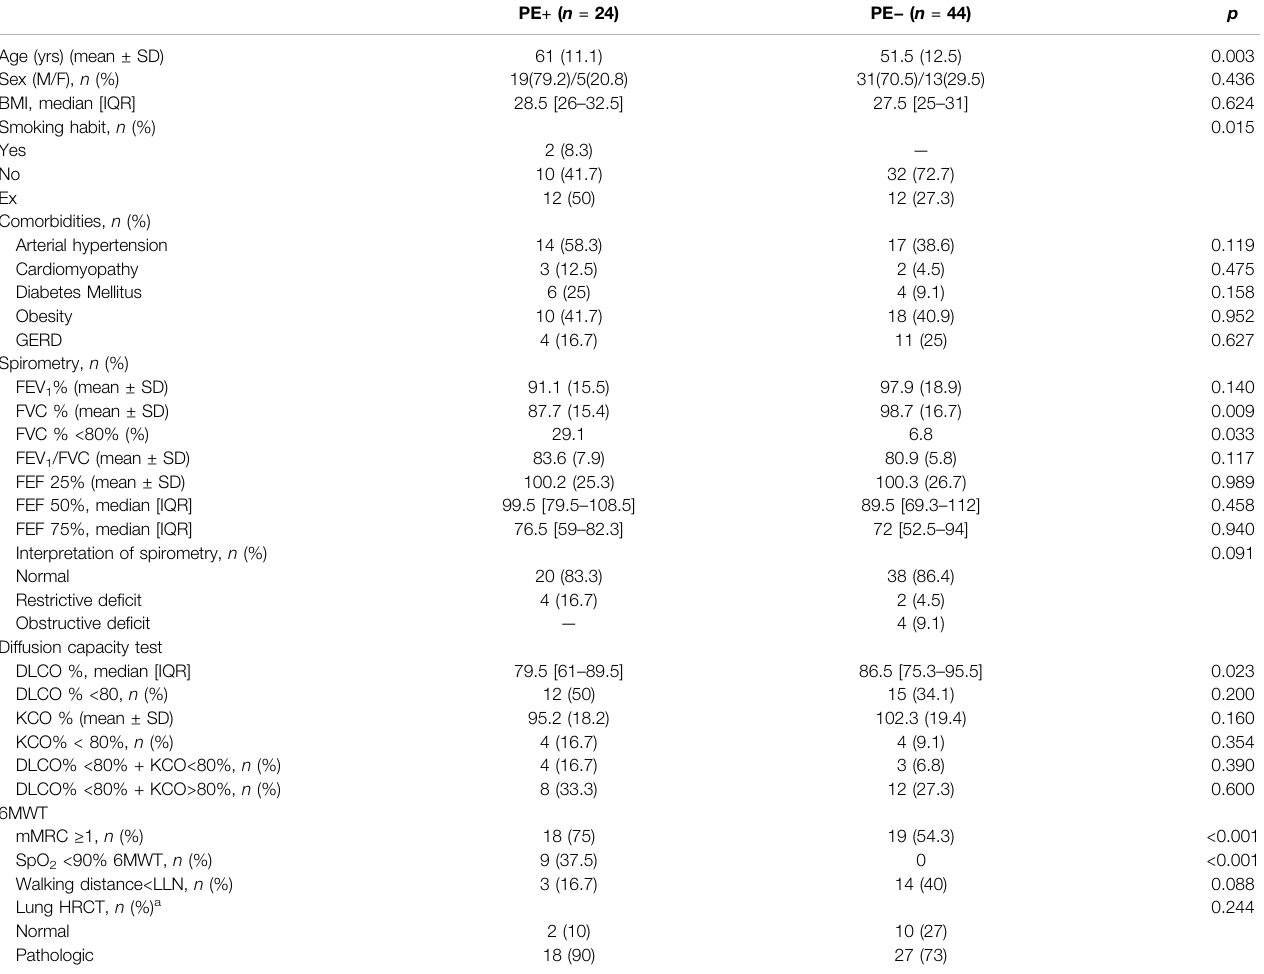
TABLE 2 | Comparison of baseline characteristics between PE+ and PE − subgroups. PE + ( n = 24) PE − ( n = 44)